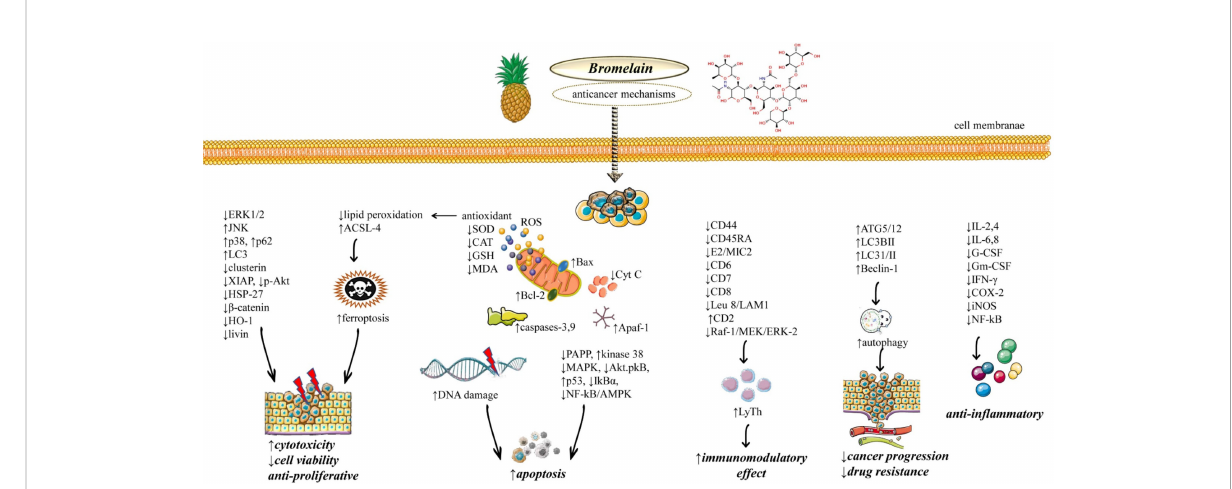
FIGURE 1 Illustrative diagram with the most representative anticancer molecular mechanisms of Bromelain. Abbreviations and symbols: ↑ increase, ↓ decrease, extracellular signal-related kinase (ERK), c-Jun N-terminal kinase (JNK), X-linked inhibitor of apoptosis protein (XIAP), Heat shock protein 27 (HSP27), Heme oxygenase-1 (HO-1), long-chain fatty acyl-CoA synthetase 4 (ACSL4), reactive oxygen species (ROS), superoxide dismutase.(SOD), Glutathione (L- g -glutamyl-L-cysteinyl-glycine; GSH), malondialdehyde (MDA), Bcl-2 Associated X (Bax), B-cell lymphoma 2 (Bcl-2), Pro-Apoptotic Apoptosis Protease – Activating Factor 1 (Apaf-1), mitogen-activated protein kinase (MAPK), serine/threonine protein kinase (Akt), nuclear factor-kappa B (NF- k B), cluster of differentiation 44 (CD44), serine/threonine kinase (Raf1), mitogen-activated protein kinase (MEK), Autophagy related 5 protein (ATG5), Microtubule- associated protein 1A/1B-light chain 3 (LC3), IL (interleukin), Interferon-gamma (IFN g ), cyclooxygenase-2 (COX-2), Granulocyte-macrophage colony- stimulating factor (GM-CSF), granulocyte-colony stimulating factor